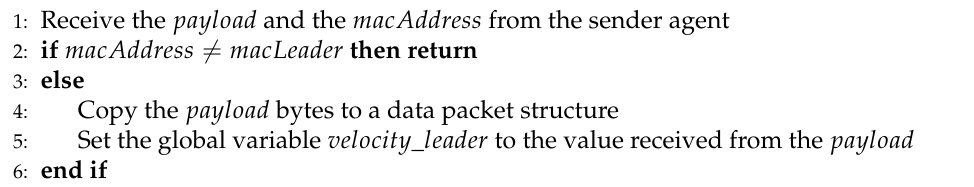
Algorithm 2 ESP-NOW routine for following